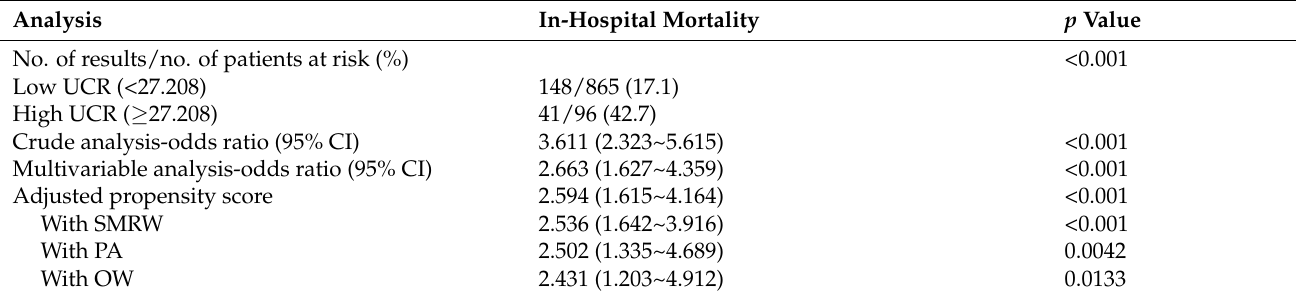
Table 5. Associations between UCR and in-hospital mortality in the crude analysis, multivariable analysis, and propensity-score